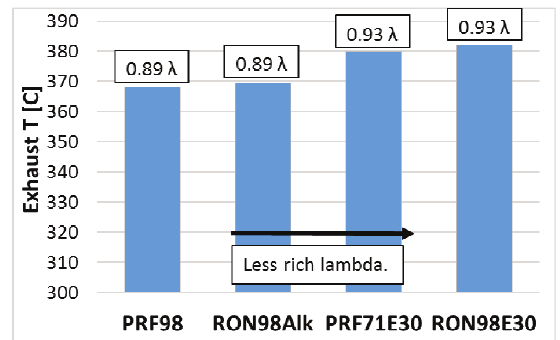
Fig. 6. Measured exhaust gas temperatures at RON conditions for each fuel